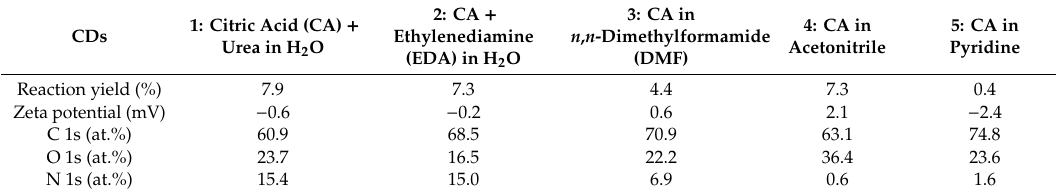
Table 1. Results of the characterization of the five carbon dots (CDs), including reaction yield, zeta potential, and atomic composition (carbon, oxygen and nitrogen, obtained by XPS